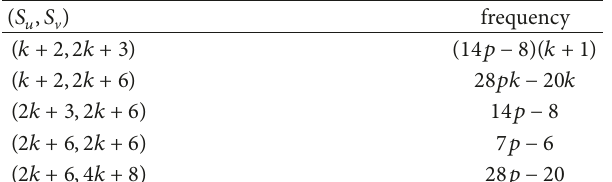
Table 2: Edge partition of 𝐹 𝑝 based on degree sum of end vertices of each